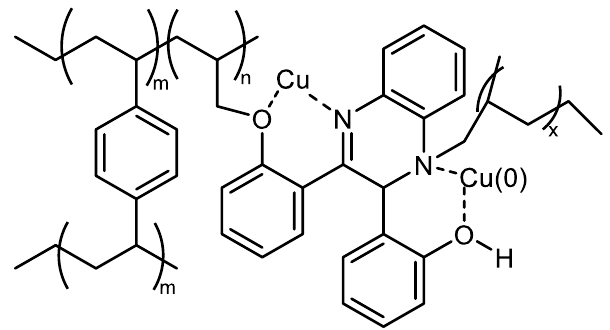
Figure 8. Structure of Cu(0)-PS-1,2-dihydroquinoxaline (PS-DHQ-Cu) catalyst [112].